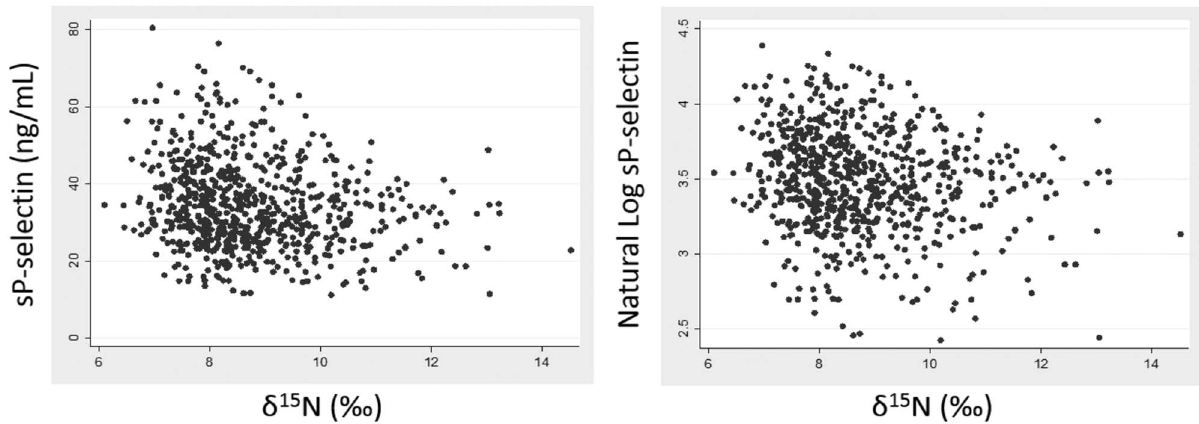
Fig 3. Relationship between δ 15 N and sP-selectin, before and after natural log transformation. A statistically significant,negative associationof the log-transformed data was obtained before (P < 0.001,R 2 = 0.039) and after adjustment for age, sex and geographical status (P < 0.001,R 2 =